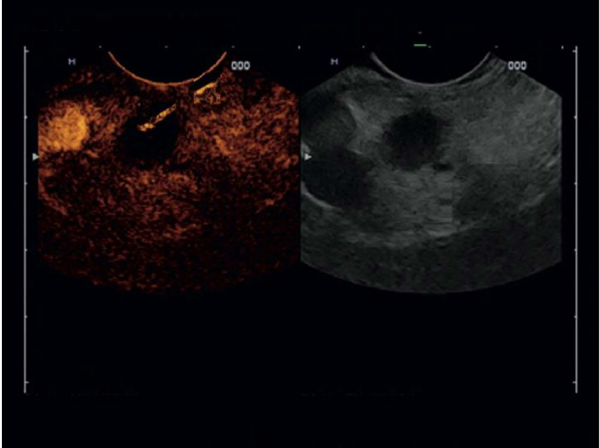
Figure 1. Endoscopic ultrasound contrast-enhanced fine-needle aspiration of a pancreatic adenocarcinoma. The hypoenhancement area of the lesion was selected as a target area for fine-needle